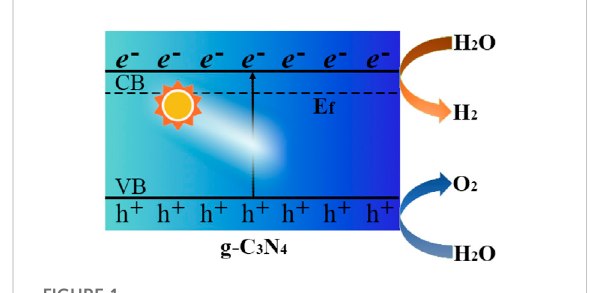
FIGURE 1 Schematic of generation of H 2 and O 2 from water with the catalysis of pristine g-C 3 N 4 under light